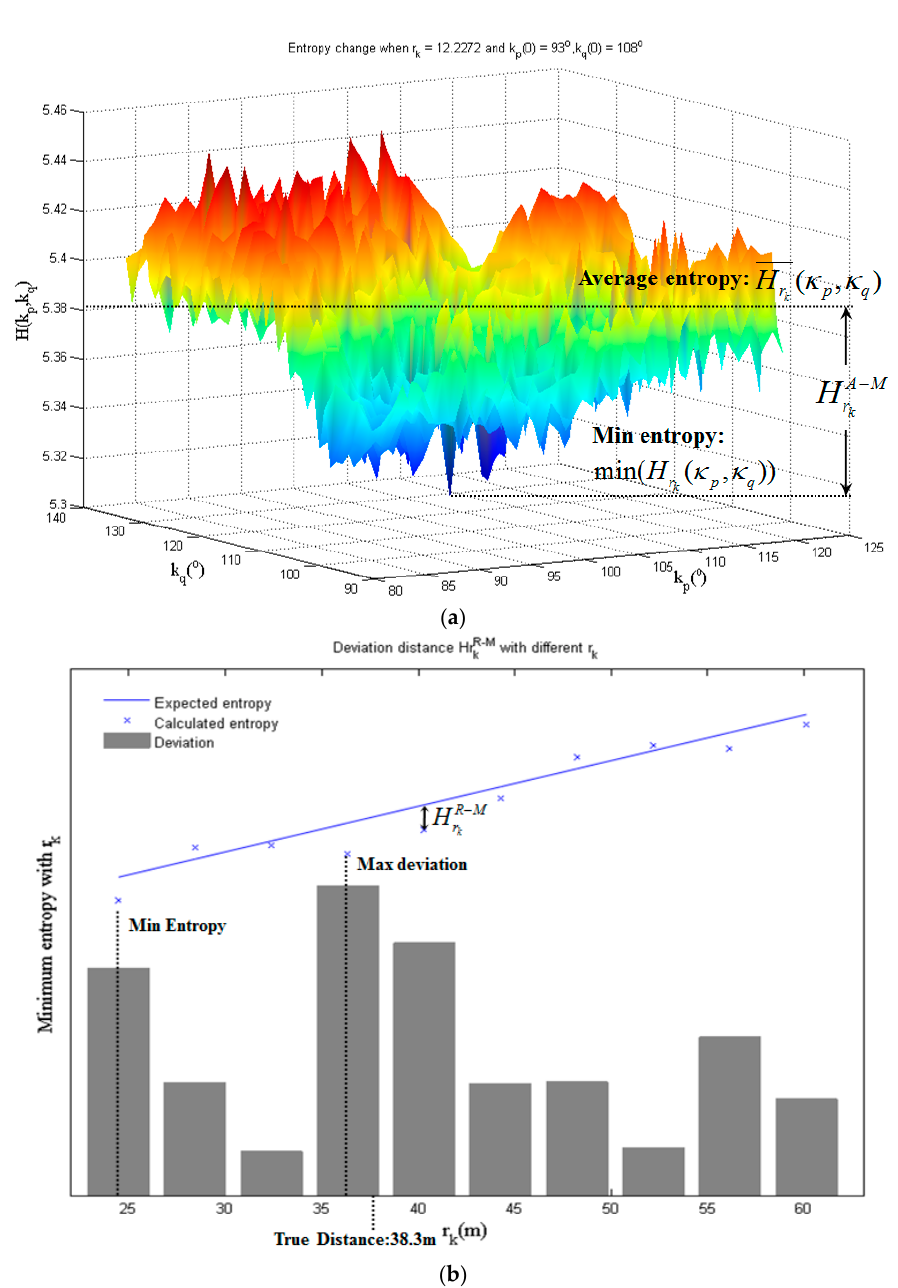
Figure 6. Two criteria for initial distance and rotation angles selection: ( a ) The entropy change when r k = 14.2272 m and κ p ( 0 ) = 93 ◦ , κ q ( 0 ) = 108 ◦ , in S1 and S2 of the first data set in Section 3.1. The calculation of H A − M r corresponding to 12.2272 m is also shown. ( b ) How H R − M r k S4 in the second data set in Section 3.2.